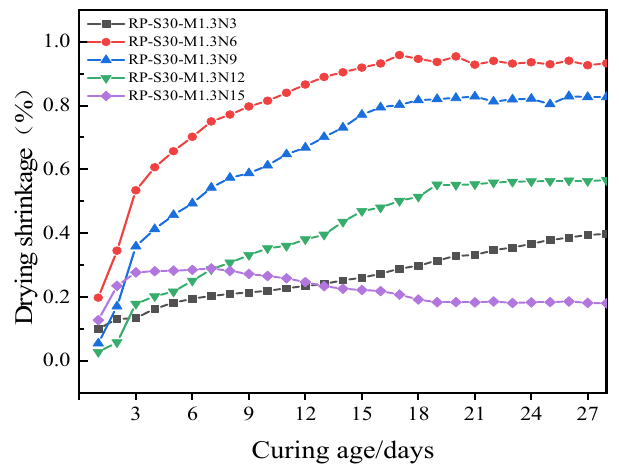
Figure 6. Drying shrinkage results of RPSG with different alkali equivalents.